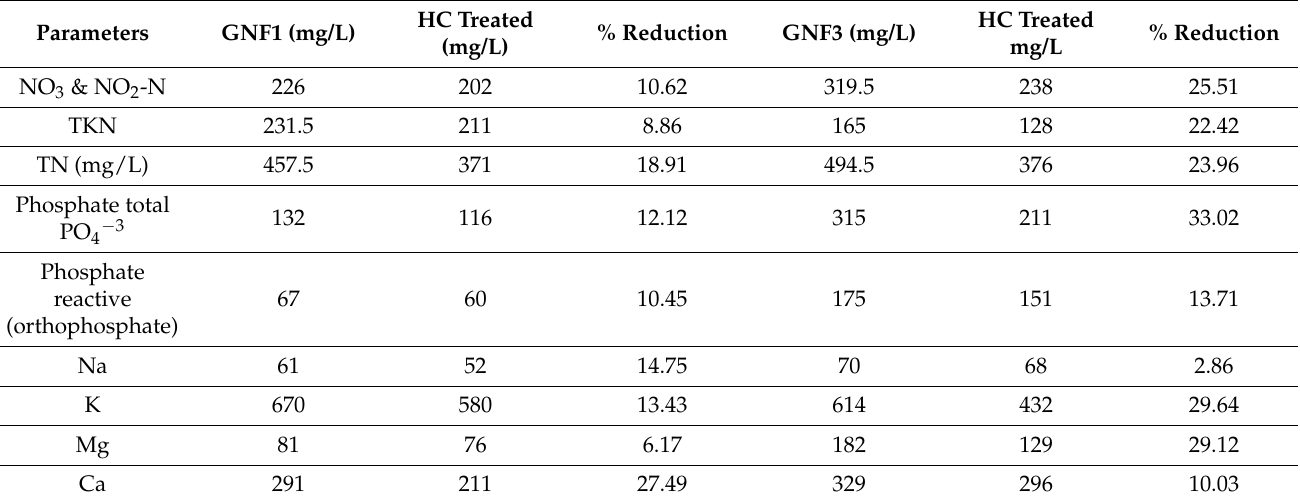
Table 6. Treatment and % reduction of different nutrient from GNF by